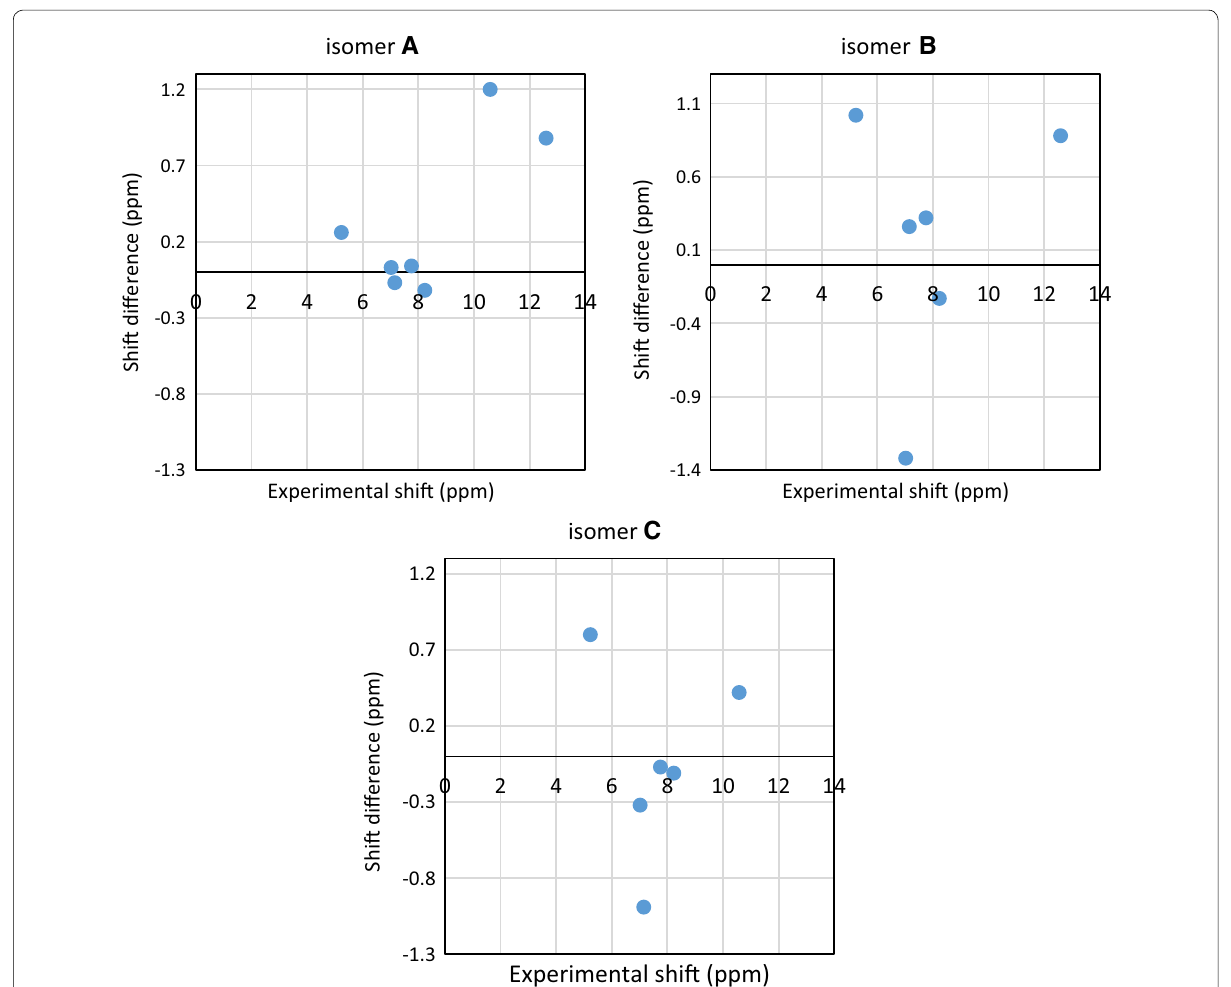
Fig. 5 Residual graphs of calculated shift (ppm) of possible isomers related to experimental shift